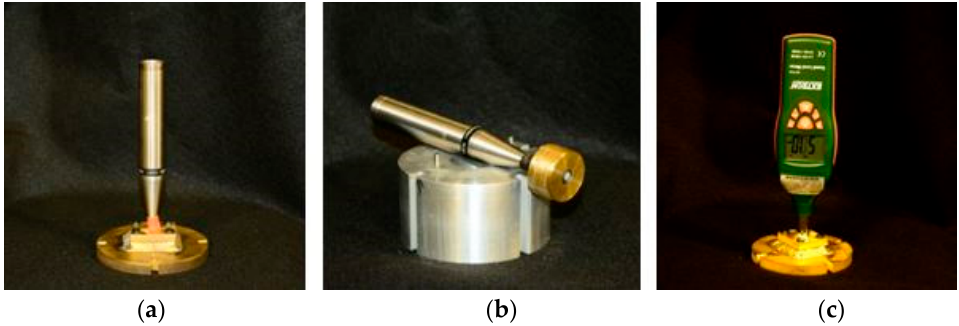
Figure 3. Picture showing the various instrumented end plates for the experimental test apparatus utilized in the study. Each of these end plates provided a different means to obtain the Iwase [12] microphone 3 measurements. The image ( a ) on the left shows a microphone embedded into the end reflection plate. In the middle image ( b ) is the sample holder as well as an instrumented movable piston-style reflection plate. The piston configuration allowed for easy adjustment of the reflection plate location. Seen on the far right in image ( c ) is a reflection plate with an NIST traceable A-weighted sound meter mounted in a pressure-tight sealed reflection plate. Option ( c ) provided the easiest method of the three, and provided the lowest-cost entry into acoustic testing.